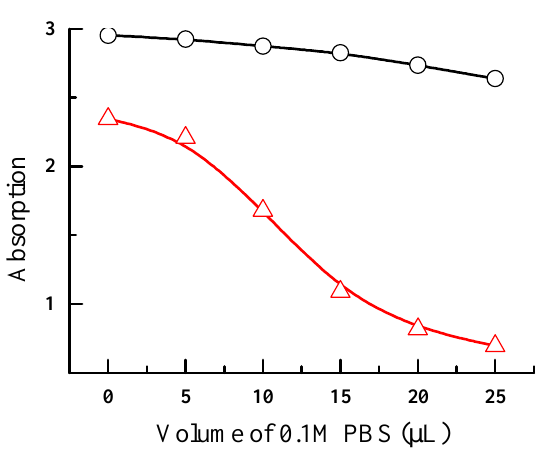
Figure 4. UV-Vis analysis of AuNPs from method II (top) and method I (bottom).